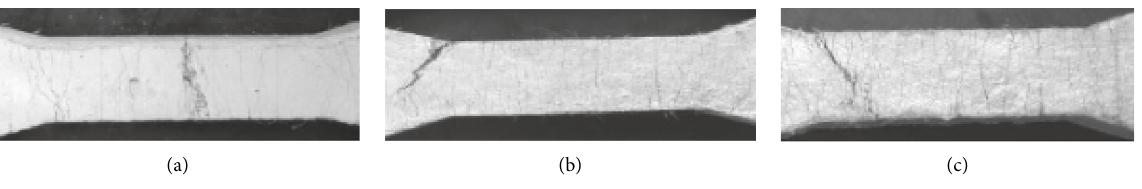
Figure 6: Failure phenomenon of PE-ECC with different water-binder ratios under fly ash: (a) 7 days, (b) 28 days, (c) 60 days.